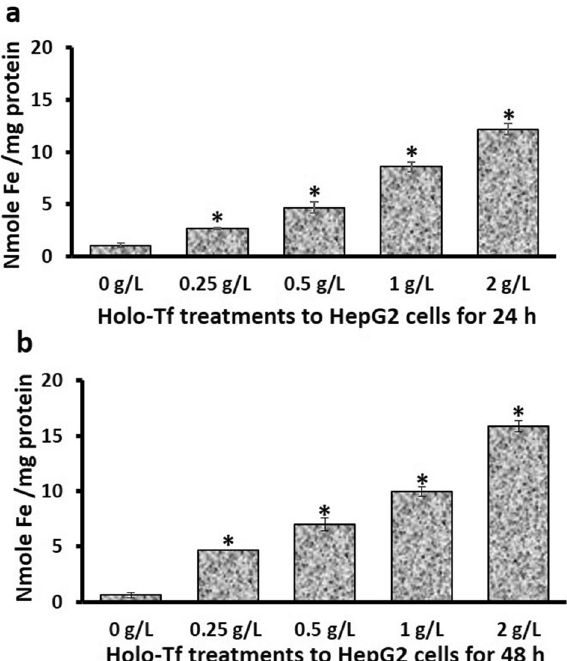
Figure 1. Holo-transferrin elevated cellular iron levels in HepG2 cells. HepG2 cells were treated with holo-Tf for 24 h ( a ) and 48 h ( b ), and cellular iron levels were determined by ICPMS. Data is presented as mean ± SEM (n = 3). * p < = 0.01 compared to untreated control (0